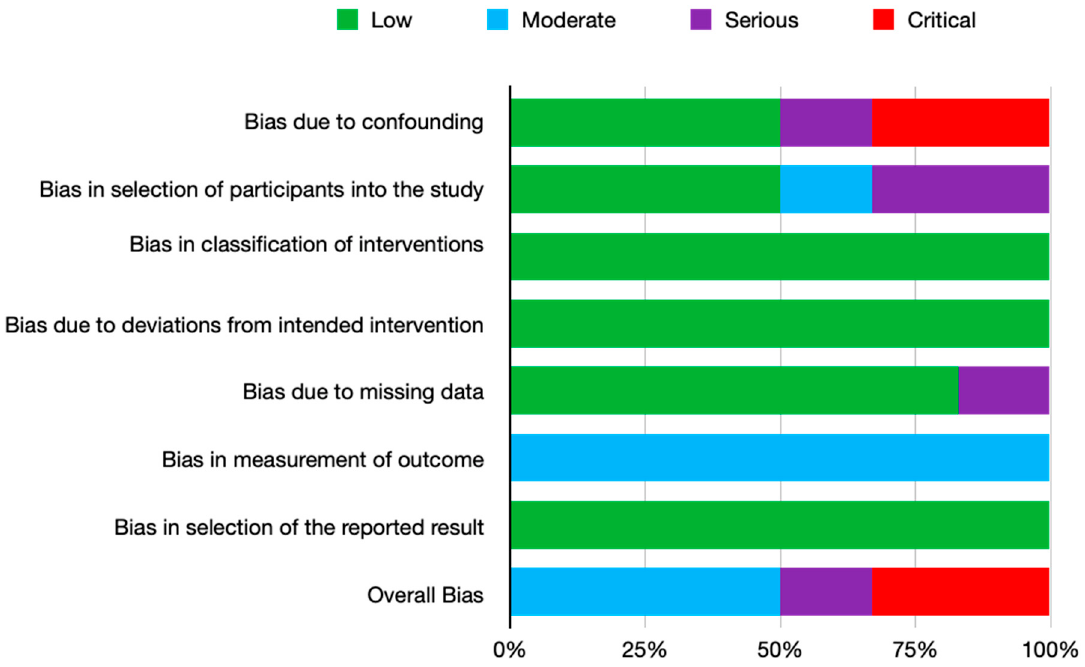
Figure 2. Summary of the risk of bias of included non-randomized trials with the ROBINS-I tool.